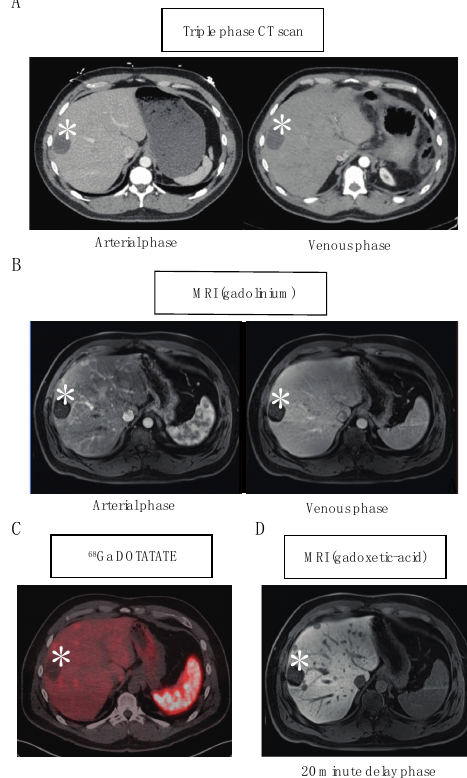
Figure 1. Representative example demonstrating NETLM detection for one patient with different imaging modalities including ( A ) triple-phase CT scan (arterial and venous phases) ( B ) standard MRI with gadolinium contrast (arterial and venous phases) ( C ) 68Ga DOTATATE PET CT imaging (fused phase) and ( D ) MRI with hepatocyte-specific contrast agent gadoxetic acid (20 min delay phase). * symbol denotes hepatic cyst demonstrating that each representative image corresponds to the same anatomic